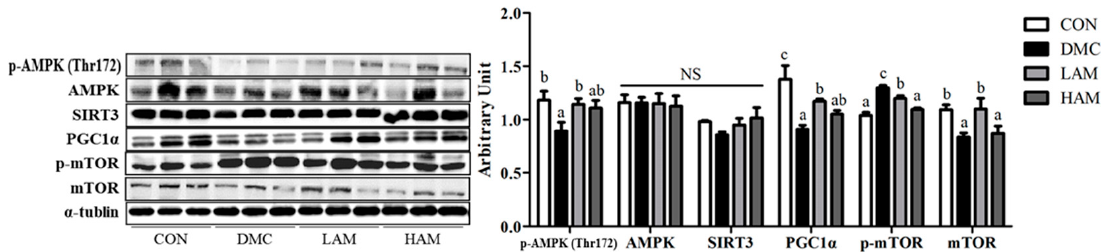
Figure 8. Effect of AME on energy metabolism in T2DM mice All values are reported as mean and SEM. Values with the different superscript letter were significantly different ( p < 0.05; ANOVA with post-hoc Duncan’s multiple range test). n = 6 mice in each group CON, normal control group (negative control); DMC, type 2 diabetic control group (positive control); LAM, diabetic group supplemented with low dosage (50 mg/kg BW) of AME; HAM, diabetic group supplemented with high dosage (100 mg/kg BW) of AME.